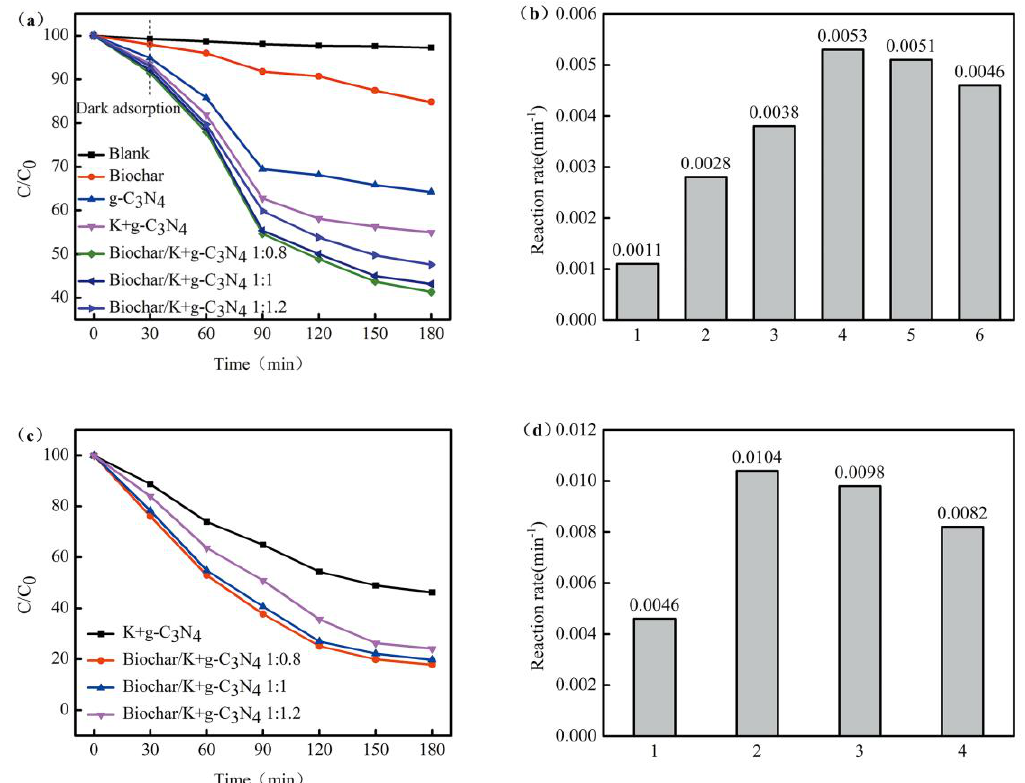
Figure 6. ( a ) Photocatalytic degradation curve of naphthalene in the first protocol and ( b ) the corresponding apparent rate constants (1-Biochar, 2-g-C 3 N 4 , 3-K+g-C 3 N 4 , 4-Biochar/K+g-C 3 N 4 1:0.8, 5- Biochar/K+g-C 3 N 4 1:1 and 6-Biochar/K+g-C 3 N 4 1:1.2). ( c ) Photocatalytic degradation curve of naphthalene in the second protocol and ( d ) the corresponding apparent rate constants (1-K+g-C 3 N 4 , 2-Biochar/K+g-C 3 N 4 1:0.8, 3- Biochar/K+g-C 3 N 4 1:1 and 4-Biochar/K+g-C 3 N 4 1:1.2).